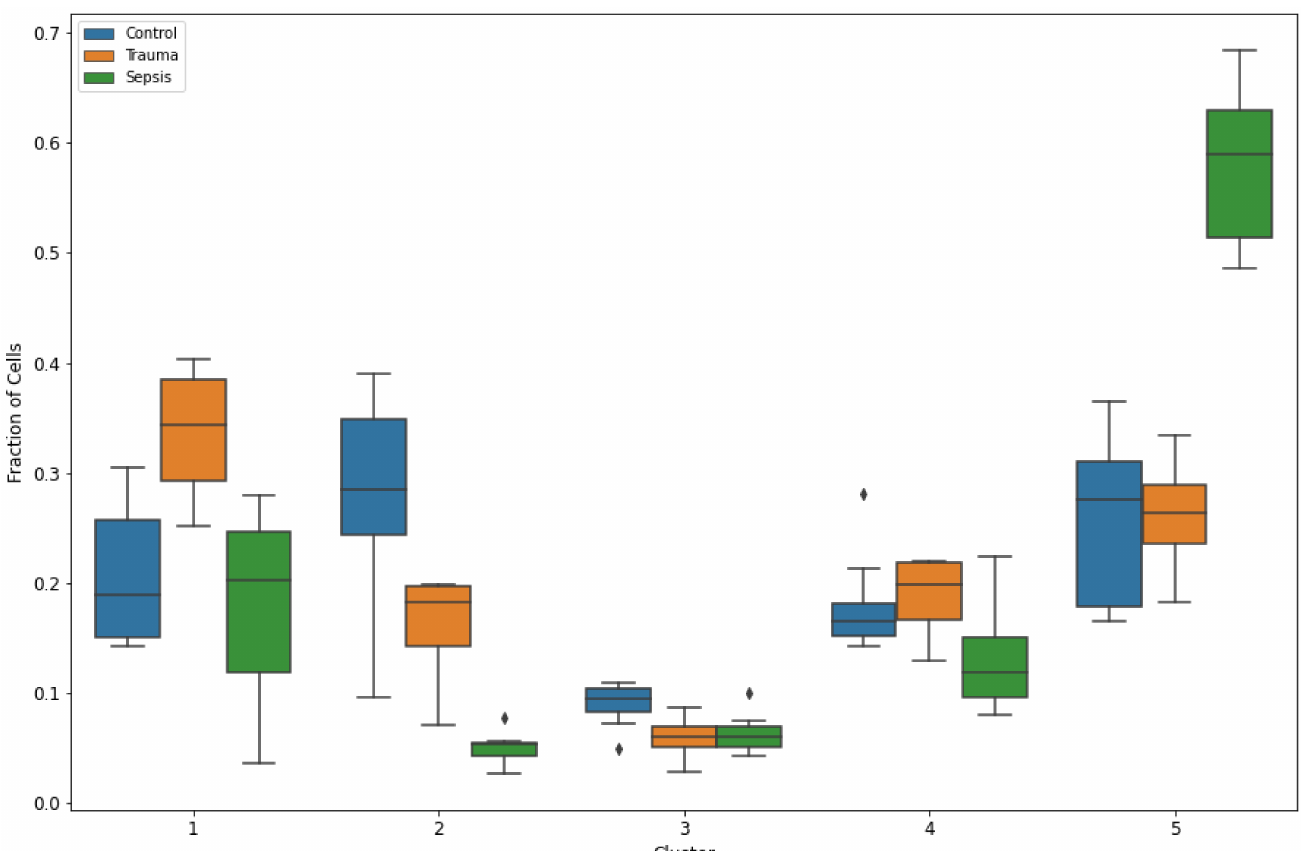
Figure 2. Fraction of cells in the different clusters for each patient group. In cluster 1, a relatively high proportion of cells of trauma patients were found, in cluster 2 and 3 this was true for control patients. In cluster 5, a high proportion of cells of sepsis patients were found. Clusters 1, 4, and 5 correspond to neutrophils, cluster 2 corresponds to lymphocytes, cluster 3 to monocytes. The black diamonds annotate outlier values (>1.5 interquartile